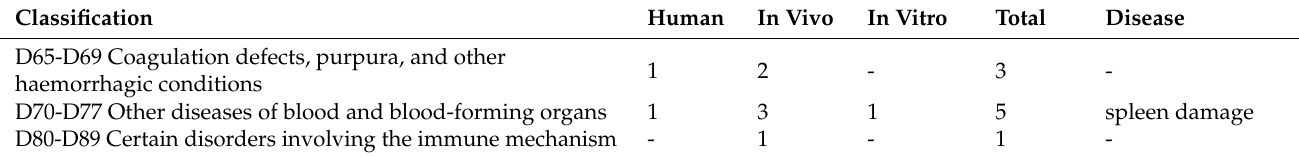
Table 15. The statistics of pharmacological results and its major diseases of SMC by experimental type in III Diseases of the blood and blood-forming organs and certain disorders involving the immune mechanism of ICD-10.